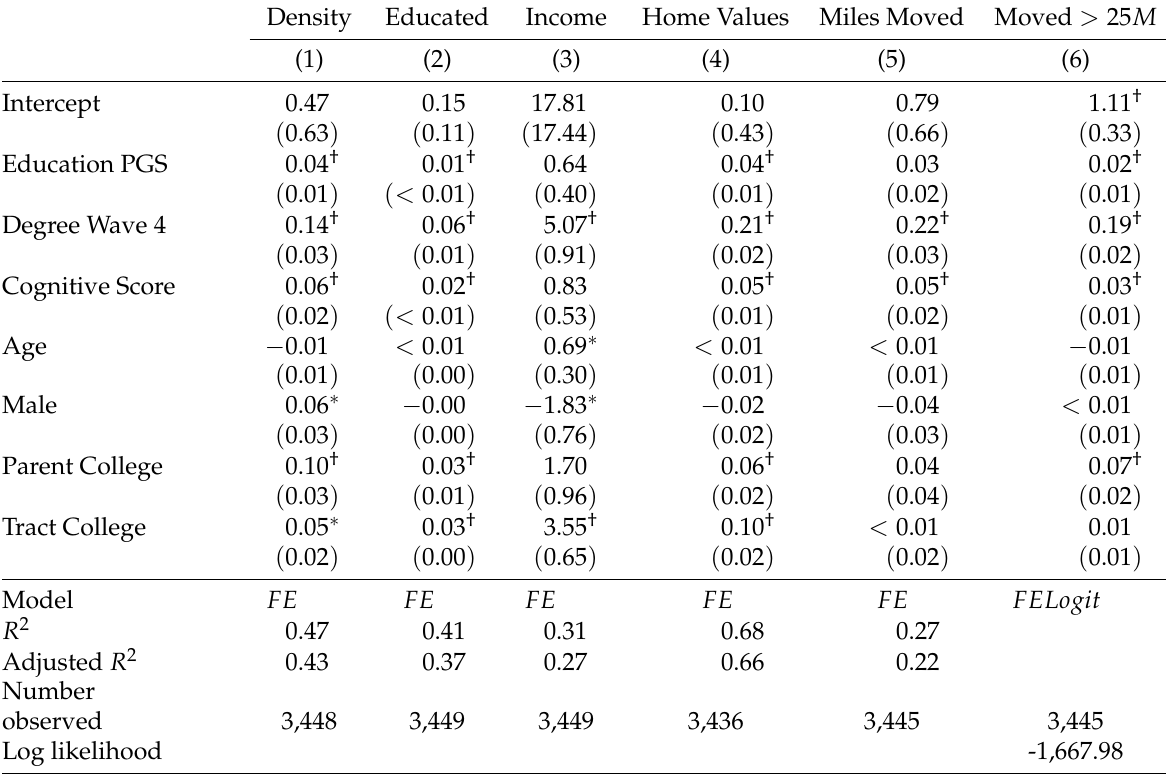
Table 1: Wave 4 neighborhood attainment outcomes; unrelated, European subsample, wave 1 school fixed